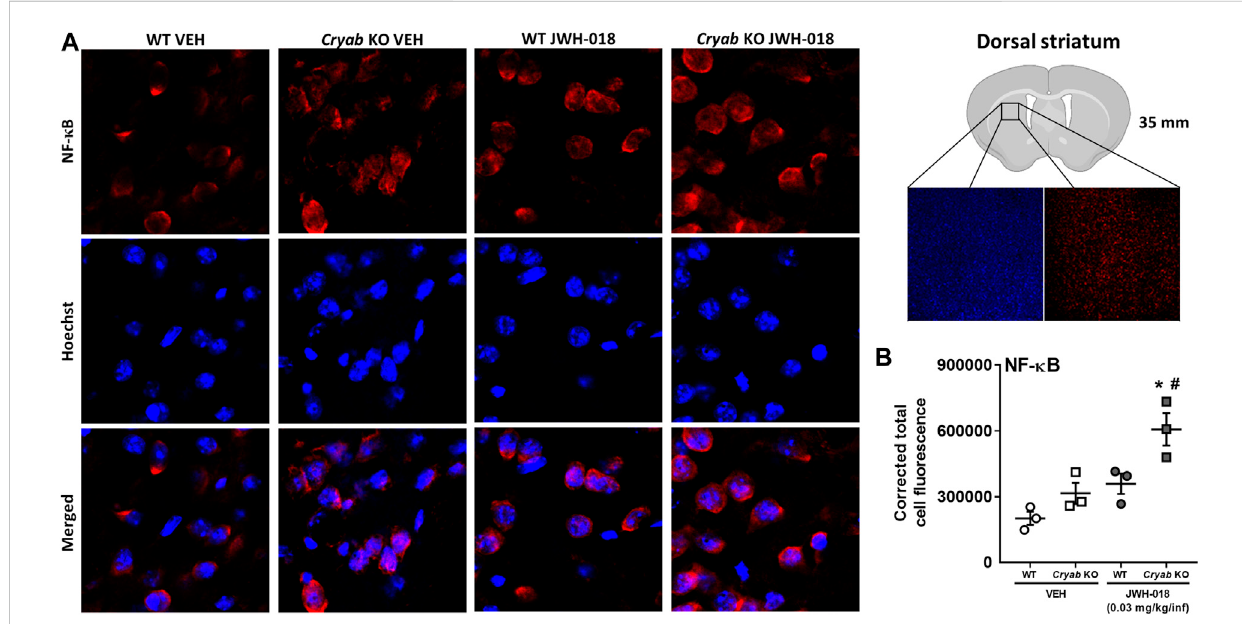
FIGURE 7 NF- κ B immunoreactivity in mice from JWH-018 self-administration. (A) Immuno fl uorescence analysis of NF- κ B and Hoechst staining in VEH- or JWH-018-exposed WT and Cryab KO mice at ×150 magni fi cation (merged images are shown). (B) Analysis through ImageJ determined the